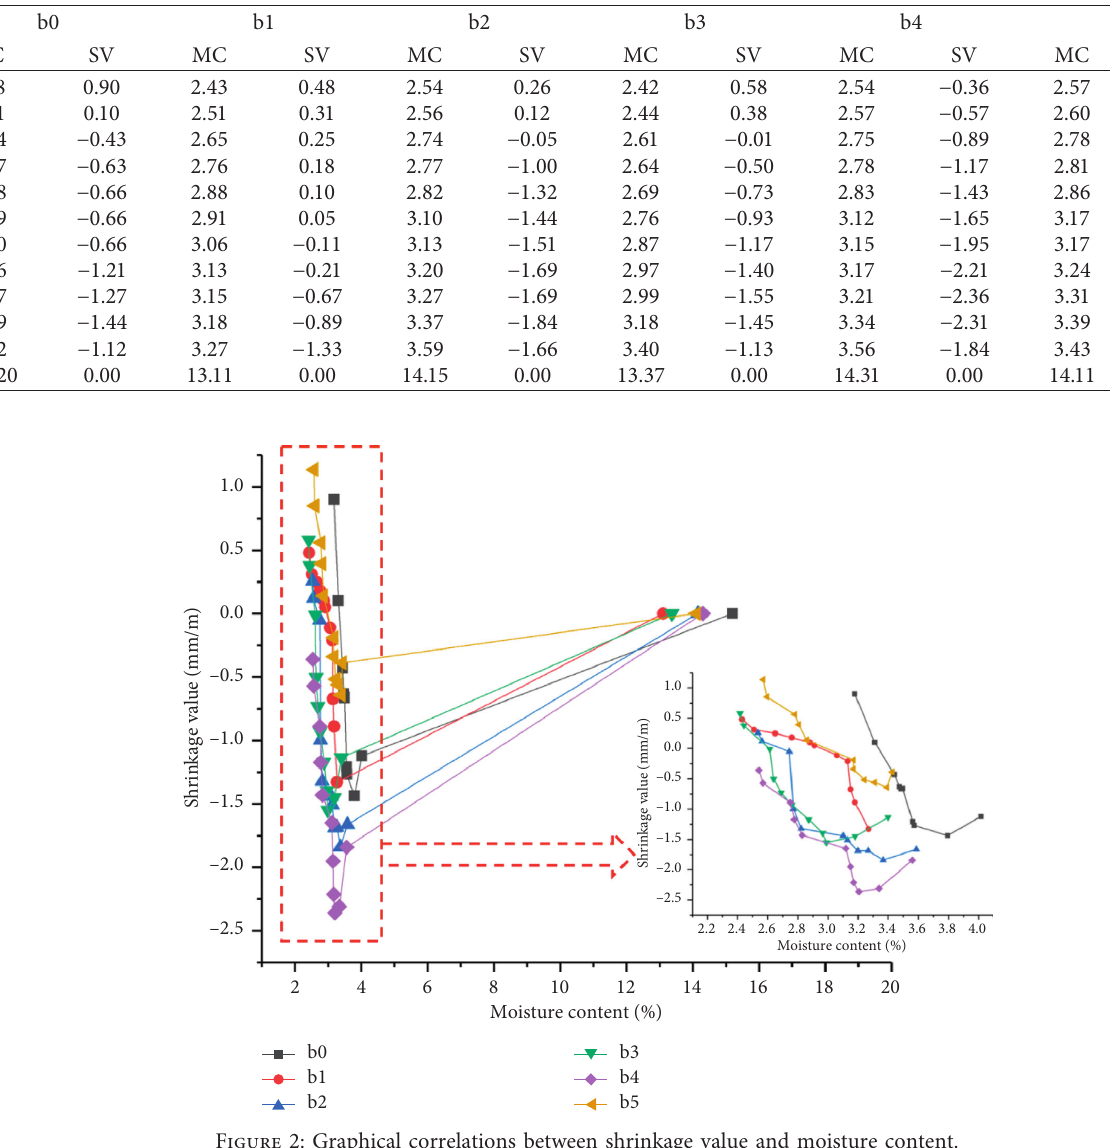
Table 4: Experimentally determined moisture contents (MC) and shrinkage values (SV).